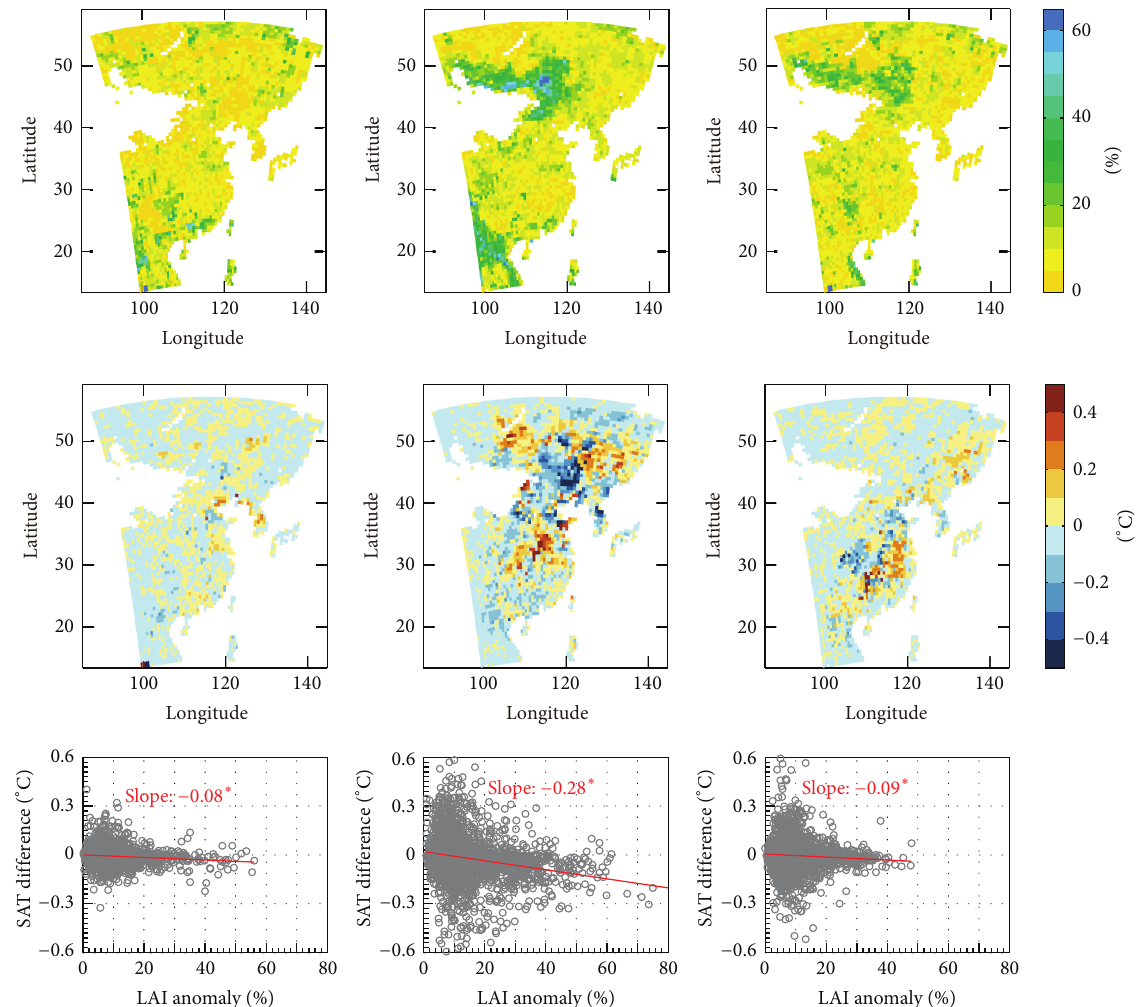
Figure5:Themaximum(positive)anomaliesofLAIfrom2002to2009(toppanel),thedifferencesofsimulatedsurfaceairtemperature(SAT) by DYC and FIX (DYC minus FIX; middle panel), and the grid cell-based spatial correlations between the LAI anomalies and SAT differences (bottom panel; the red straight line is the best fitting line and the slope as unit of 0.01 ∘ C per 1% LAI; the stars represent the confidence level higher than 99.9%) for spring (left panel), summer (middle panel), and autumn (right panel).